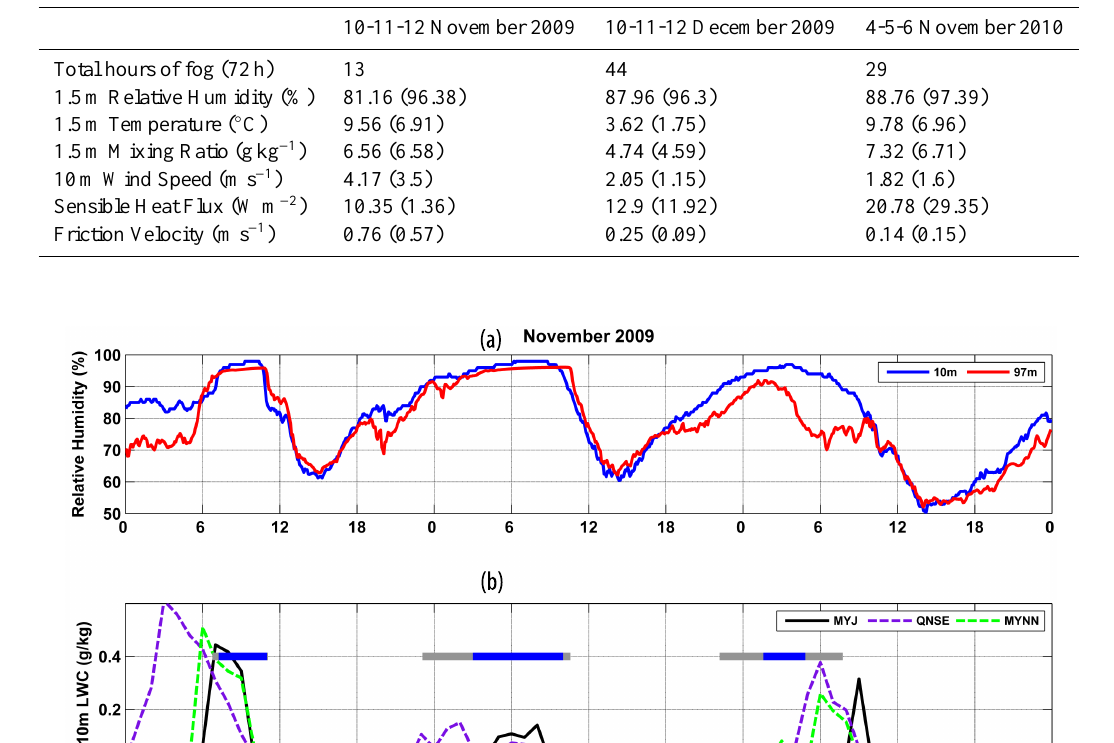
Table 1. Mean observed values for di ff erent parameters for complete periods (3 days) and during strictly fog moments (in brackets).